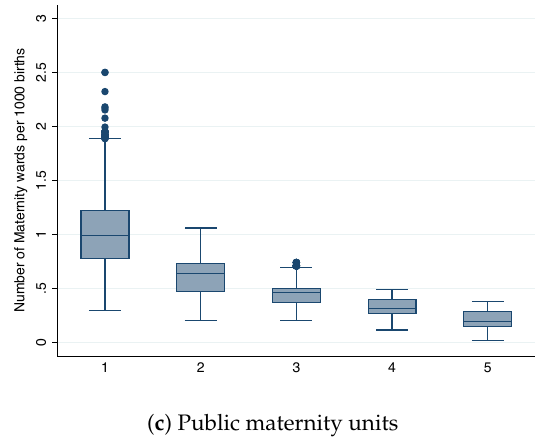
Figure 2. Number of maternity units per 1000 births, by birth